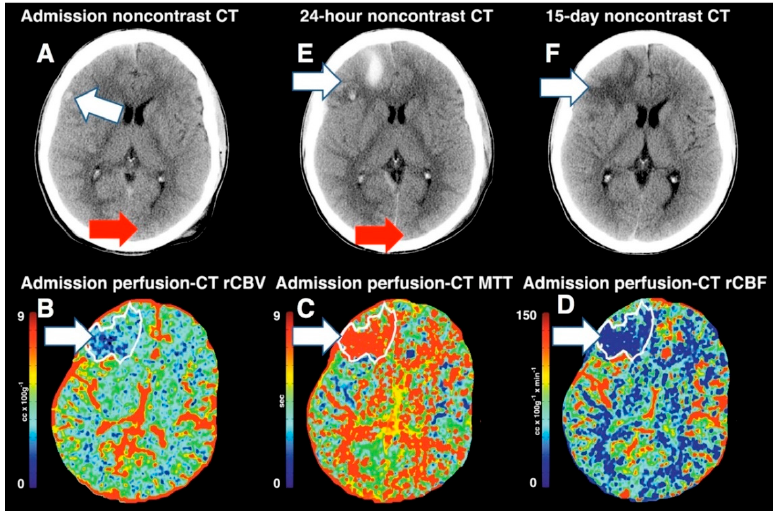
Figure 5. Noncontrast and perfusion computed tomography (PCT) images from a patient with severe traumatic brain injury (TBI). ( A ) Noncontrast CT at admission revealed a small hemorrhagic contusion in the right frontal lobe (arrow). Admission PCT images demonstrates a large territory of decreased regional cerebral blood volume (rCBV) ( B ), increased mean transit time (MTT) ( C ) and decreased regional cerebral blood flow (rCBF) ( D ). Follow-up noncontrast CT at 24 h ( E ) demonstrates increased areas of hemorrhagic contusion in the right frontal lobe where the perfusion abnormality was seen. Follow-up noncontrast CT at 15-days ( F ) demonstrates evolving hemorrhagic contusion and encephalomalacia in the right frontal lobe, which corresponds to the same distribution that is seen on the perfusion-CT on admission. Reprinted with permission from